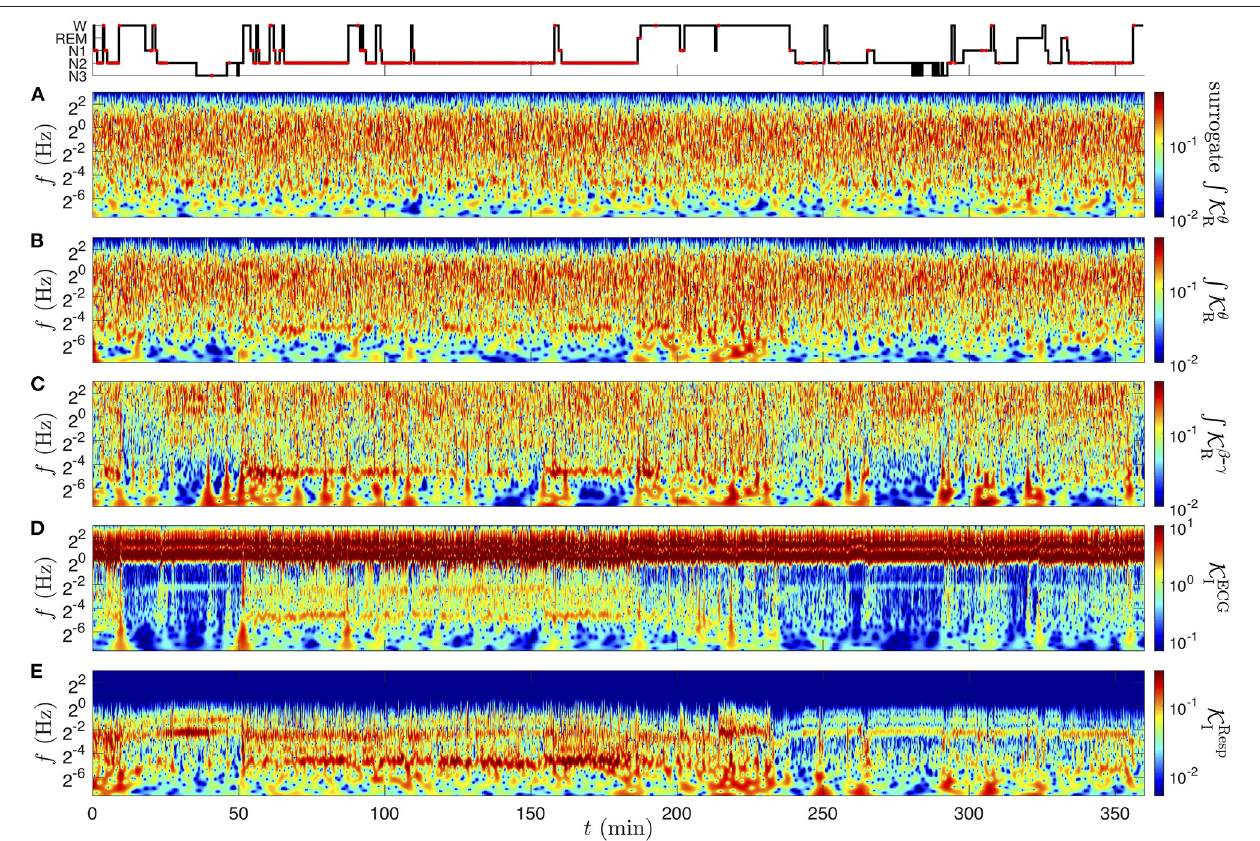
K ECG K β - γ R , (D) frequency modulation in the ECG I , (E) R